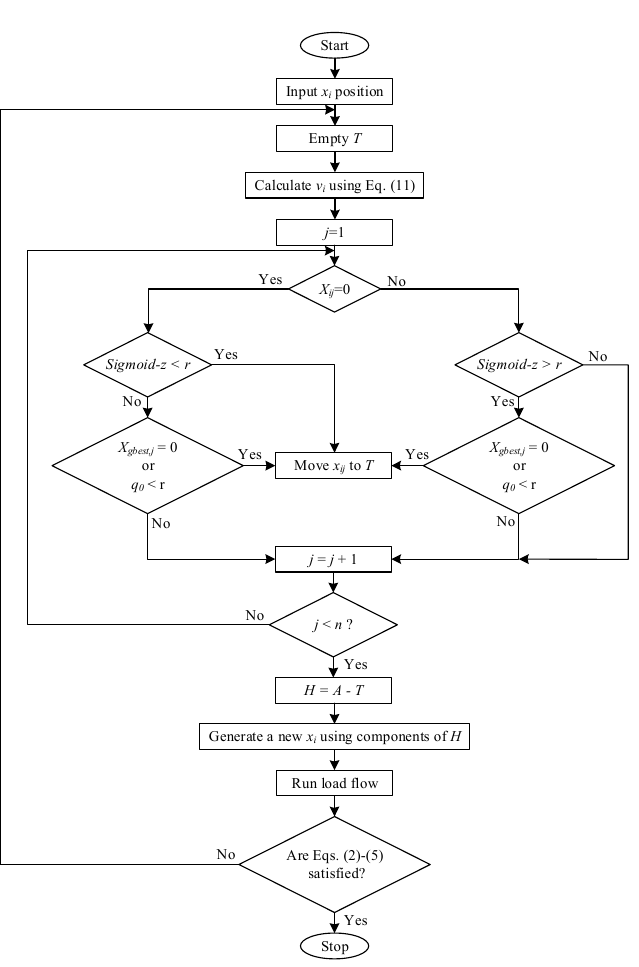
Figure 1. Flowchart of proposed algorithm for movement of particles.